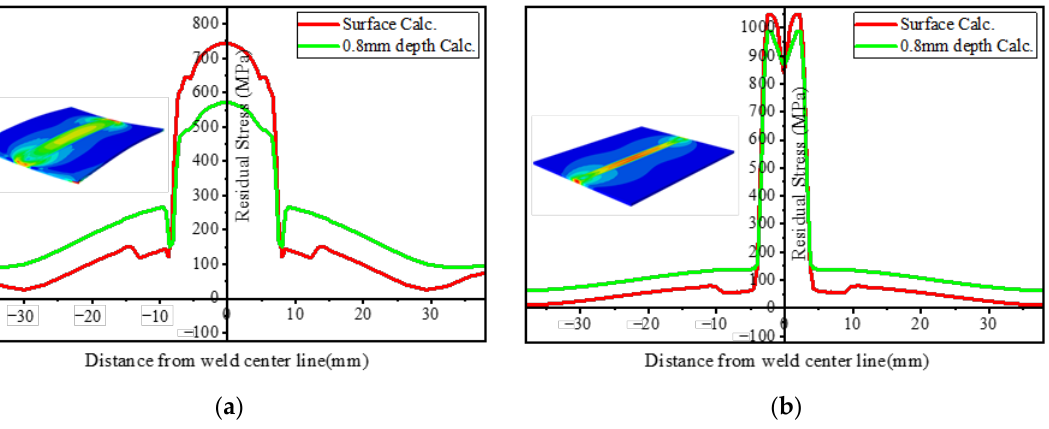
Figure 24. Mises stress distribution of residual stress at different depths: ( a ) TIG weldment, ( b ) LBW